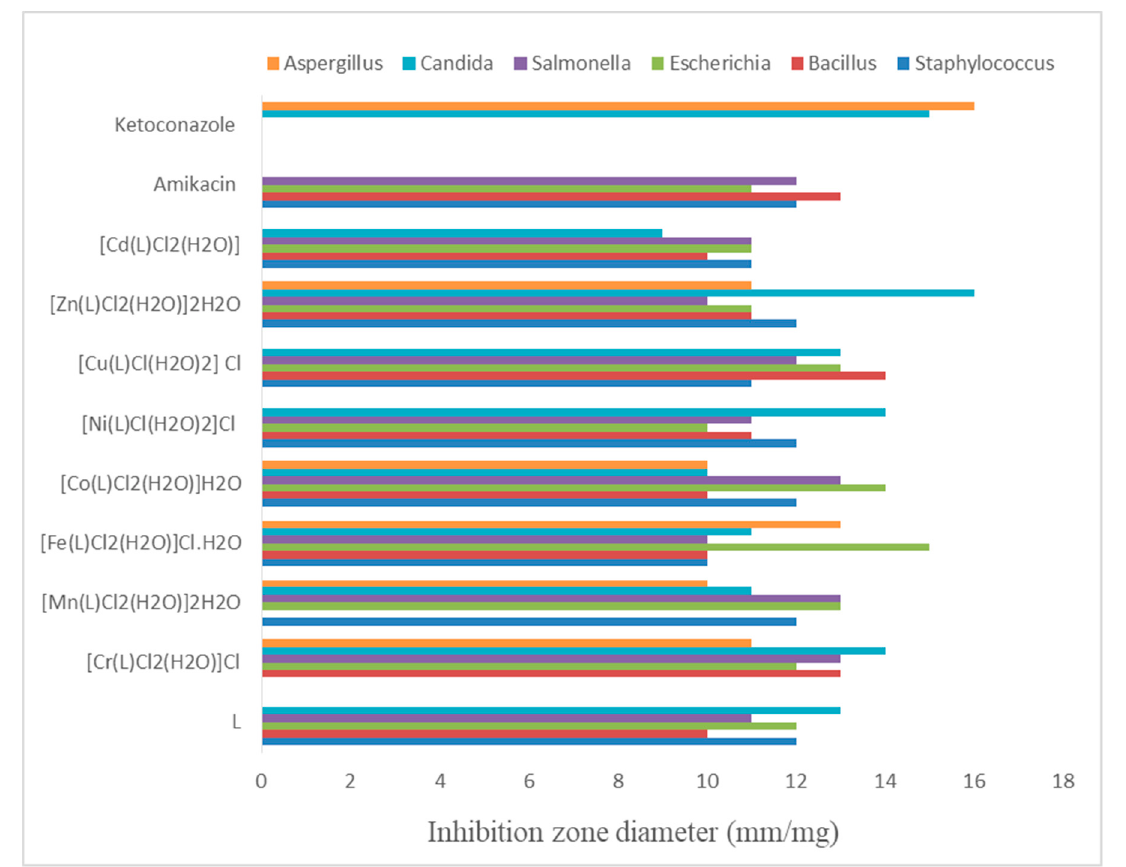
Figure 7. Biological activity of azo dye ligand (L) and its complexes.